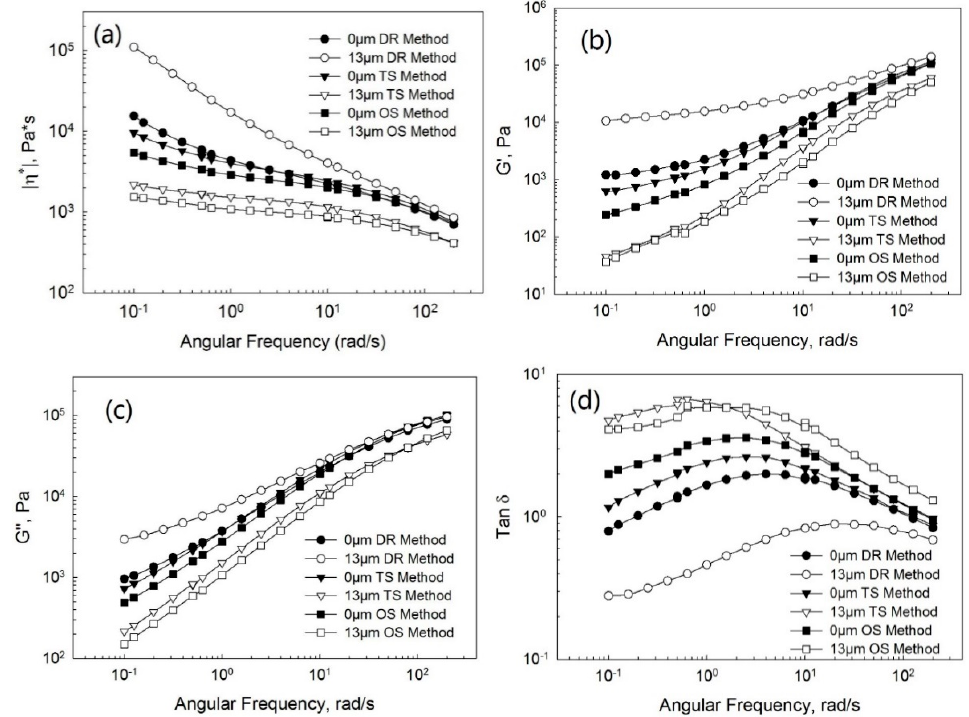
Figure 8. Complex viscosity ( a ), storage moduli ( b ), loss moduli ( c ), and loss tangent ( d ) as a function of the frequency at the ultrasonic amplitudes of 0 µ m (without ultrasonic treatment) and 13 µ m for the PP/EPDM 50/50 blends prepared by the OS, TS, and DR